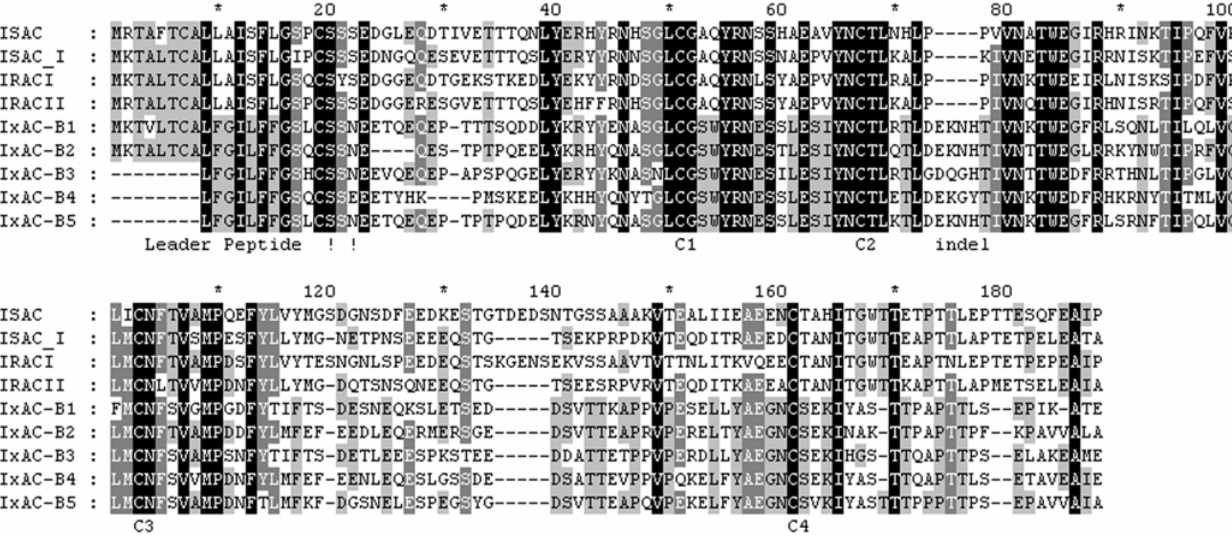
Figure 2. Alignment of Ixodesanticomplement proteins . The 7 anticomplement proteins from I. ricinus (IRAC I and II; IxAC-B1 to B5) were aligned with the prototypical anticomplement protein from I. scapularis (ISAC) and the homolog from I. pacificus (ISAC I). Individual residues printed in white on a black background are conserved in all 9 aligned sequences; white residues on a grey background are conserved in 7 or 8 of 9 entries; black residues on a grey background are conserved in 5 or 6 entries; black residues on a white background are conserved in less than 5 entries. -, gap; ! !, region of predicted signal peptide cleavage; C1 to C4, conserved cysteine residues. doi:10.1371/journal.pone.0001400.g002 PLoS ONE |